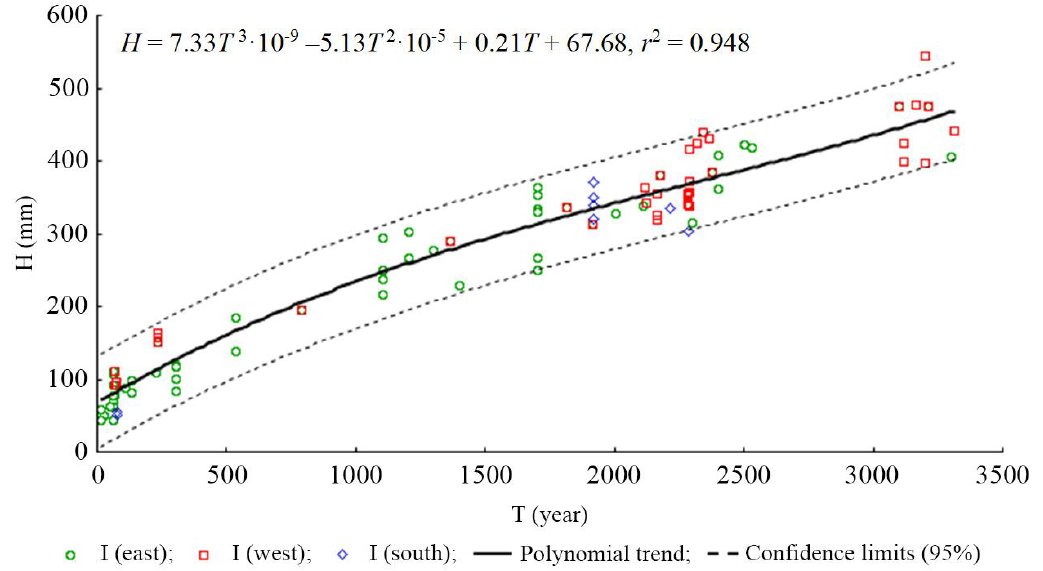
Figure 3. Chronofunctions of changes of the humus horizon (H, mm) for the soils of polygon (I)-type (see Table 2) over time (T, year). Confidence limits (P = 0.95).